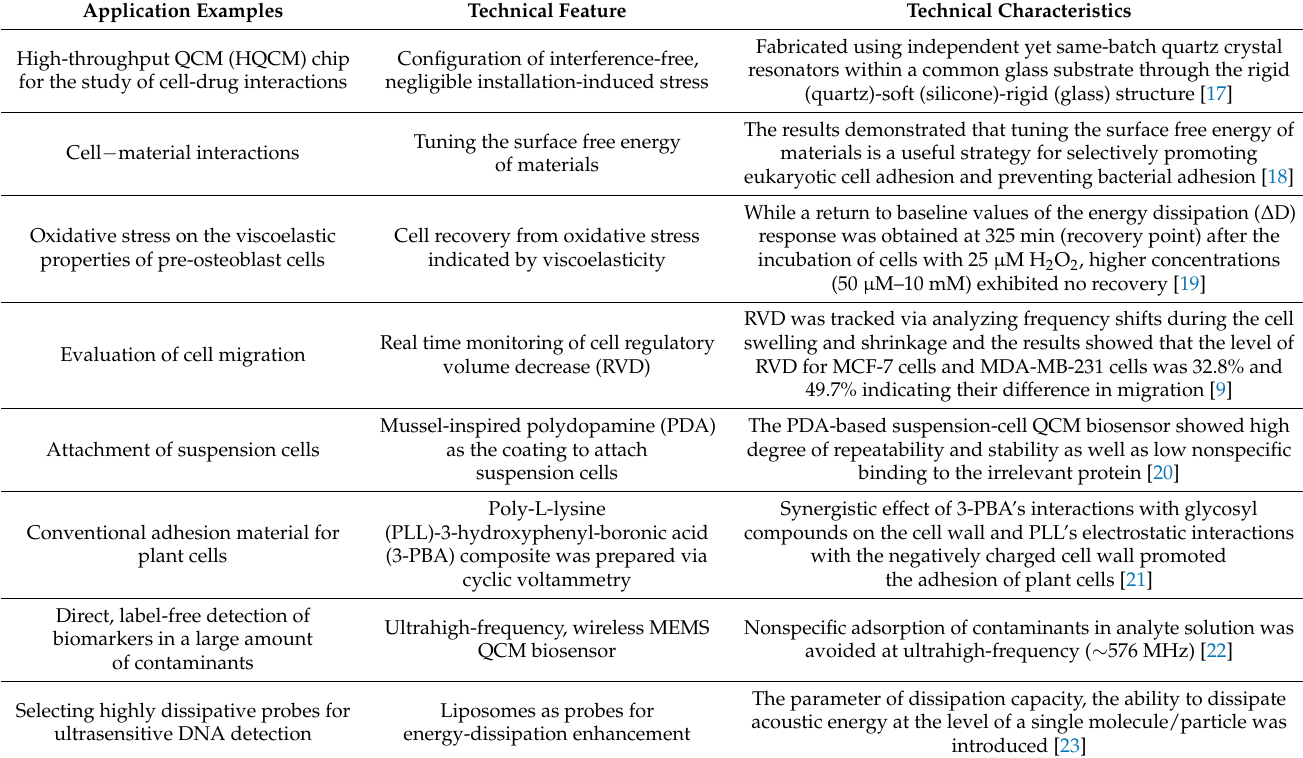
Table 1. Some of the Major Progresses of QCM Technology in Cellular and Biomolecular